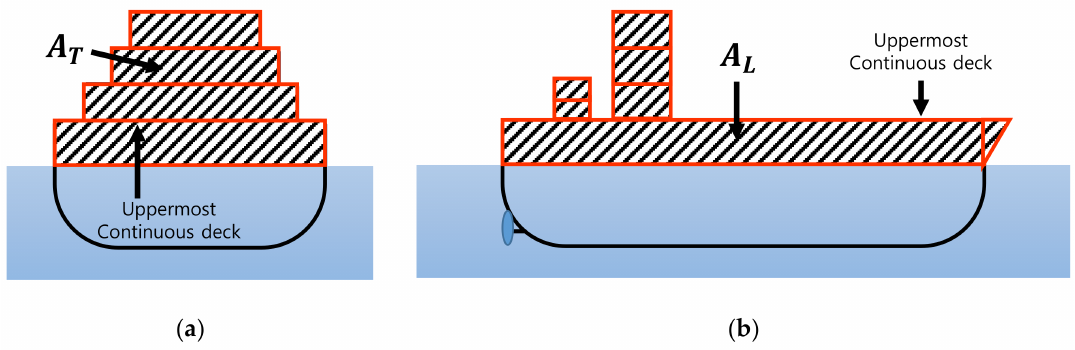
Figure 3. ( a ) Transverse projection area and ( b ) lateral projection area above the water